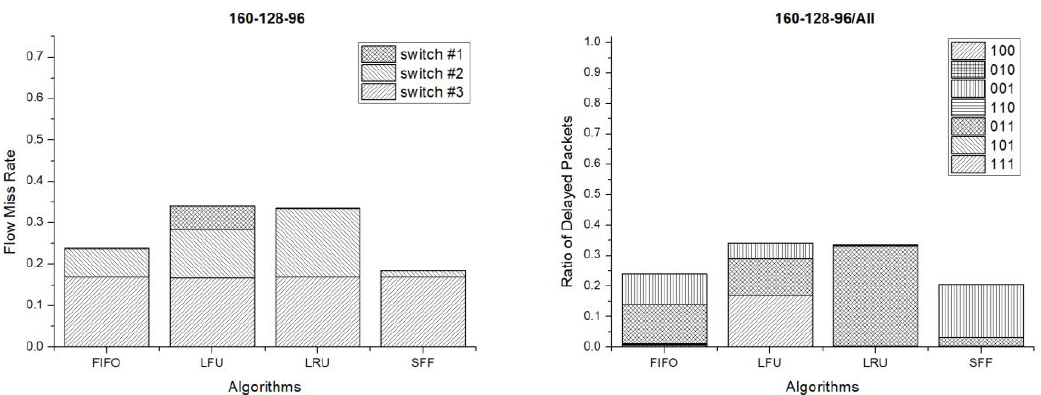
Figure 12. Experiment results with 160-128-96 flow table size.